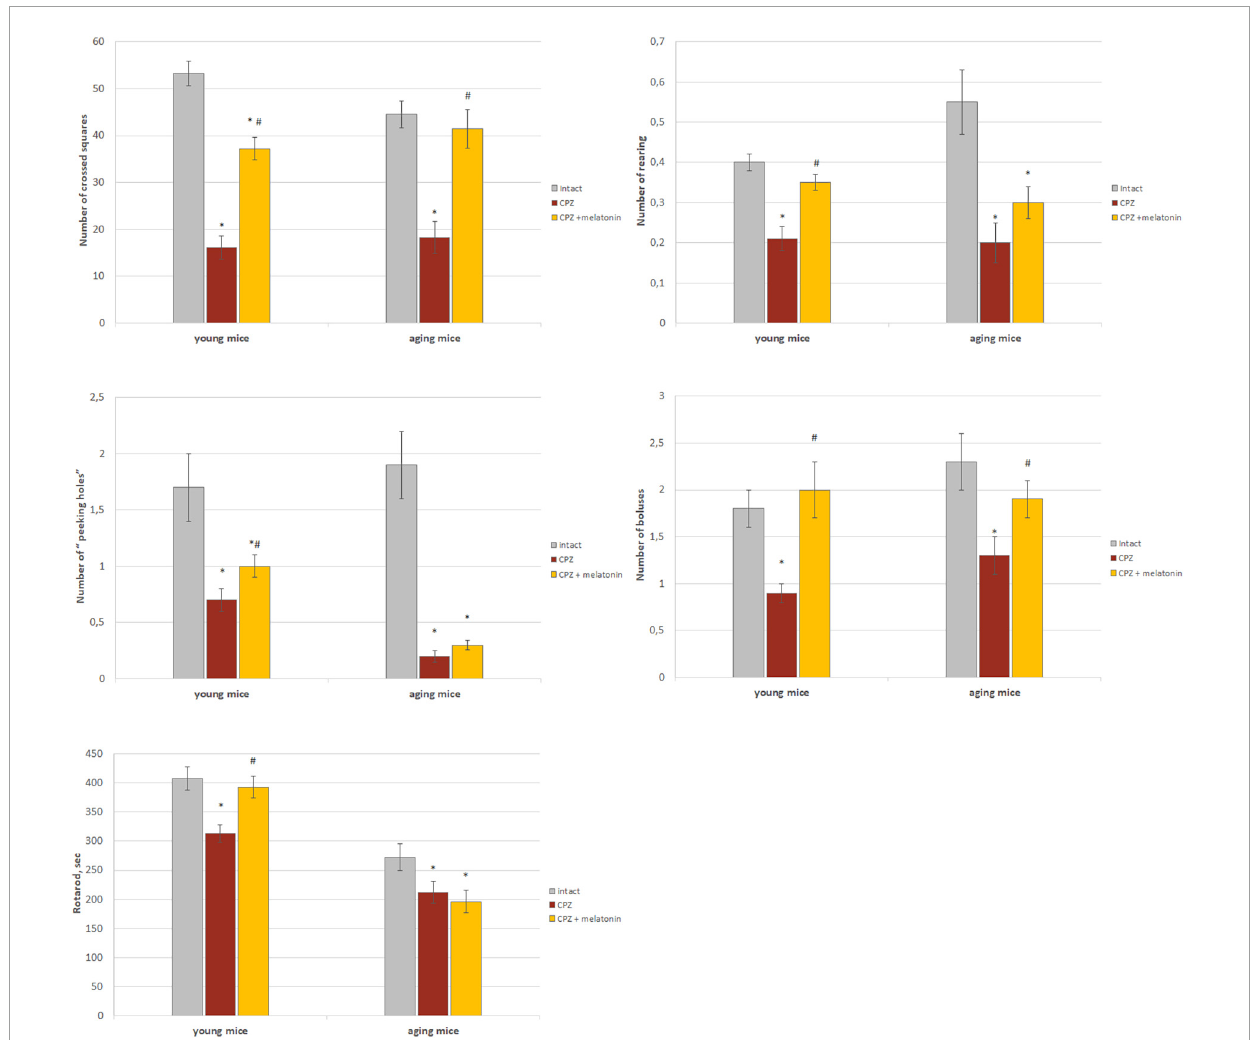
FIGURE7 The effect of cuprizone (CPZ) and CPZ + melatonin on behavioral indicators (“open field” and rotarod tests) in young and aging mice of experimental groups ( n = 15 in each group). Represented data are in 3 weeks of CPZ diet. Data are M ± SEM. ∗ p < 0.05 compared to intact group; # p < 0.05 compared to CPZ ( t